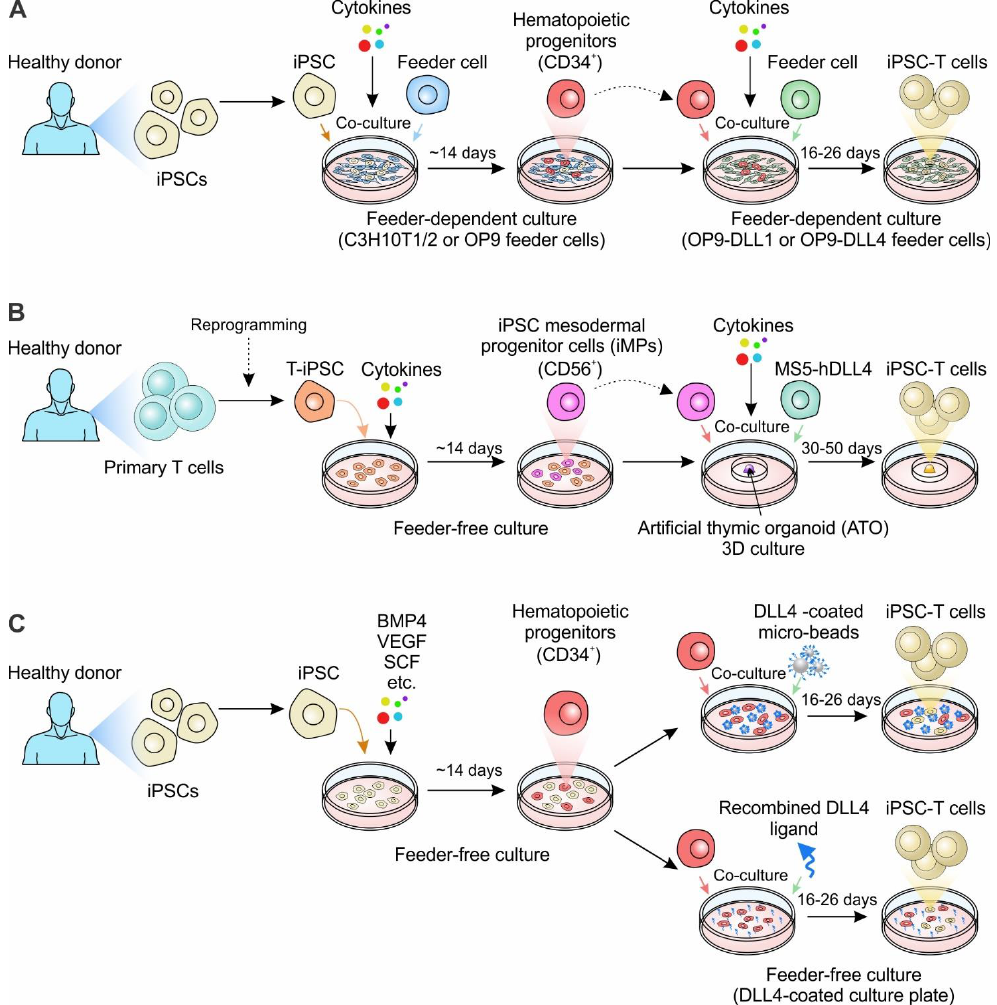
Figure 2. Generation of iPSC-derived T cell-based cell therapy. ( A ) The classic approach to generate iPSC-derived T cells. iPSCs derived from healthy donors are co-cultured with the murine bone mar- row stromal cell line C3H10T1/2 or OP9 to allow for the generation of CD34 + hematopoietic progen- itors. CD34 + hematopoietic progenitors are then enriched and co-cultured with OP9 overexpressing DLL1 or DLL4 (OP9-DLL1 or OP9-DLL4) with defined cytokines, driving the differentiation of T cells. ( B ) 3D-organoid culture to generate iPSC-derived T cells. The human primary T cells derived from healthy donors are reprogrammed to iPSCs. The T cell-derived iPSCs (T-iPSCs) are cultured in the defined cytokine cocktail to induce iPSC mesodermal progenitor cells (iMPs). The iMPs are then aggregated with mouse stromal cell line MS5 overexpressing human DLL4 (MS5-DLL4) in the air-liquid interface of the artificial thymic organoid (ATO). ( C ) Feeder-free culture systems to gen- erate iPSC-derived T cells. iPSCs are cultured in the medium with defined cytokines for two weeks to generate hematopoietic progenitors. The CD34 + progenitors are selected and reseeded either in the plate containing DLL4-coated micro-beads or plate coated with recombined DLL4 ligand. Nota- bly, for the generation of gene-engineered iPSC-T cells, the healthy donor-derived iPSCs can be re- plated with genetically-engineered iPSCs, such as CAR-engineered iPSCs.